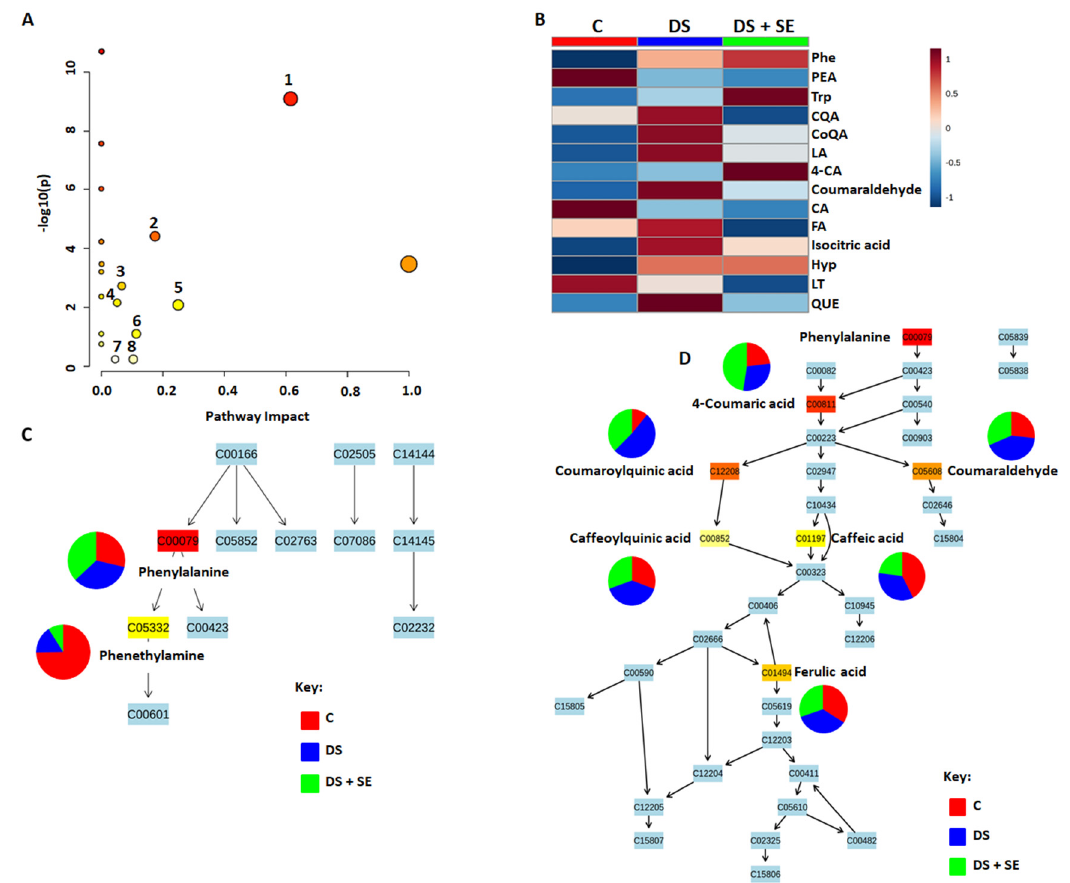
Figure 8. Summary of Metabolic Pathway Analysis (MetPA) outputs. ( A ) Representation of the global metabolome overview containing all of the matched pathways arranged by p -Values on the y -axis and pathway impact (significance) values on the x -axis. The pathway impact values refer to the cumulative percentage from the matched metabolites and the maximum importance of each pathway is 1. (1) Phenylalanine metabolism; (2) Phenylpropanoid biosynthesis; (3) Arginine and proline metabolism; (4) Flavonoid biosynthesis; (5) Stilbenoid, diarylheptanoid, and gingerol biosynthesis; (6) alpha-Linolenic acid metabolism; (7) Citrate cycle (TCA cycle); and (8) Glyoxylate and dicarboxy- late metabolism; ( B ) Heatmaps displaying differential qualitative alterations in the concentrations of selected metabolites; ( C ) Topological characteristics of the phenylalanine metabolism pathway, including quantification levels of phenylalanine and phenethylamine; ( D ) Topological